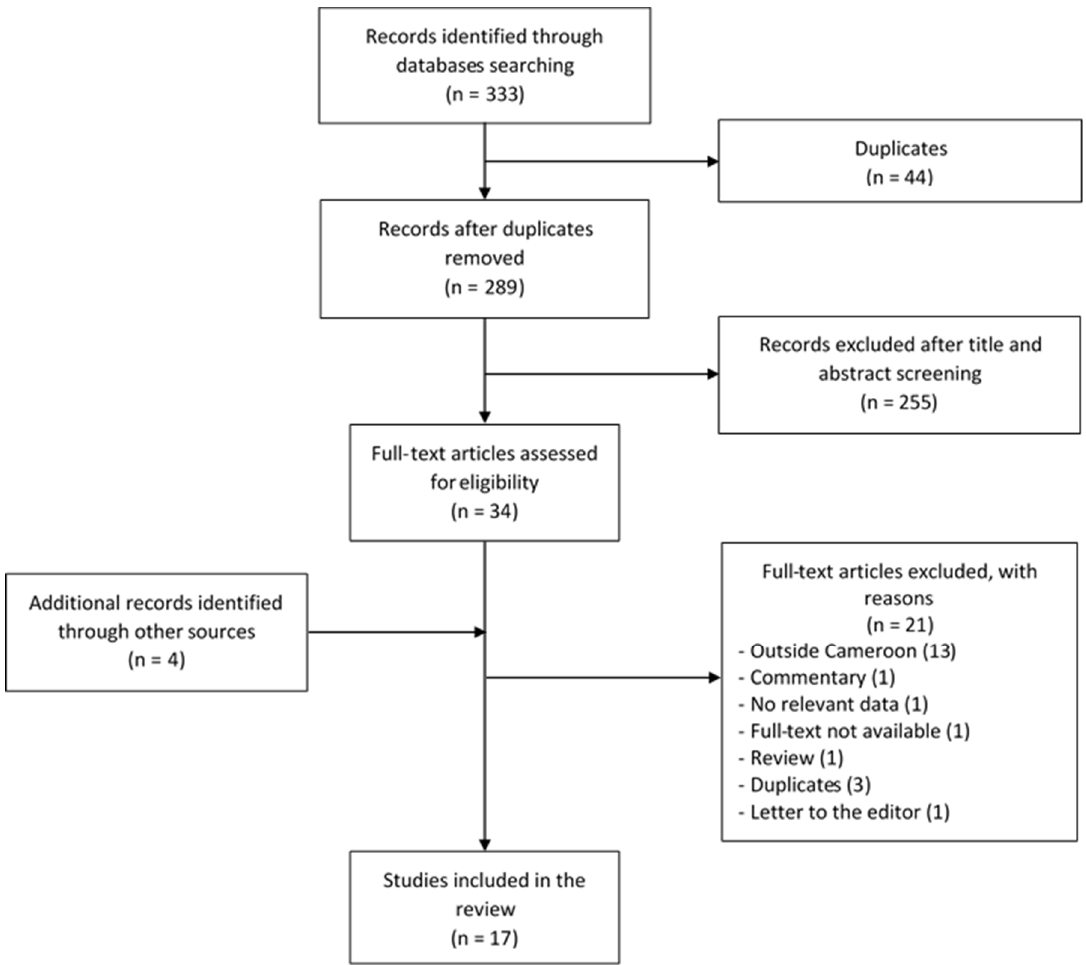
Figure 1. Flow chart of studies selection .